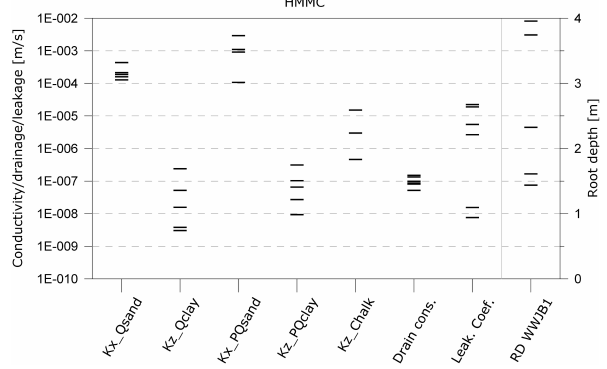
Fig. 6. Optimised parameter values for all model-domains with HMM precipitation correction.